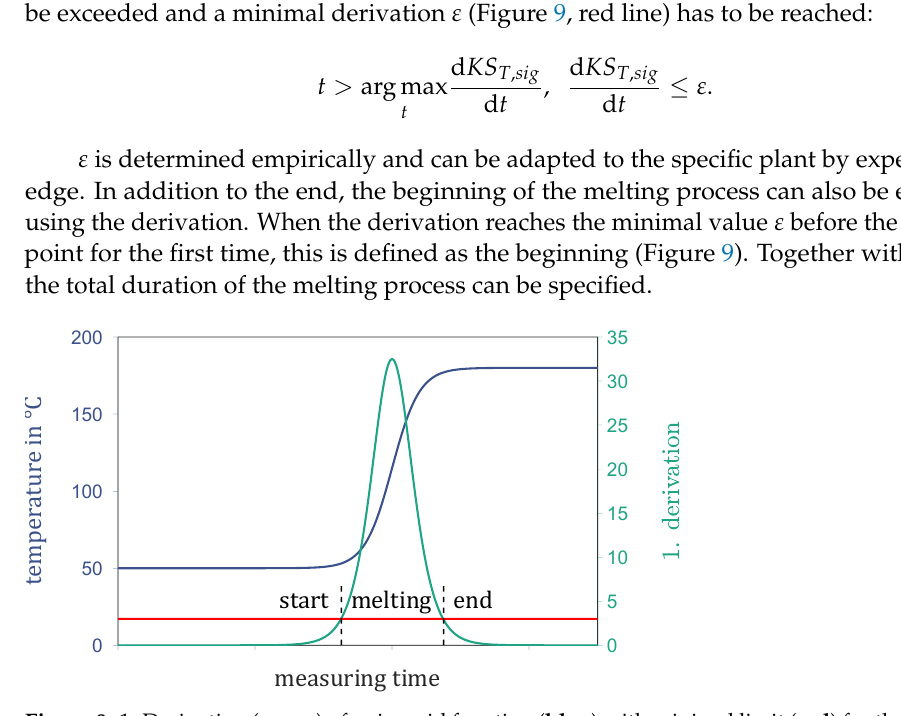
Figure 9. 1. Derivation ( green ) of a sigmoid function ( blue ) with minimal limit ( red ) for the estimated start and end of the melting